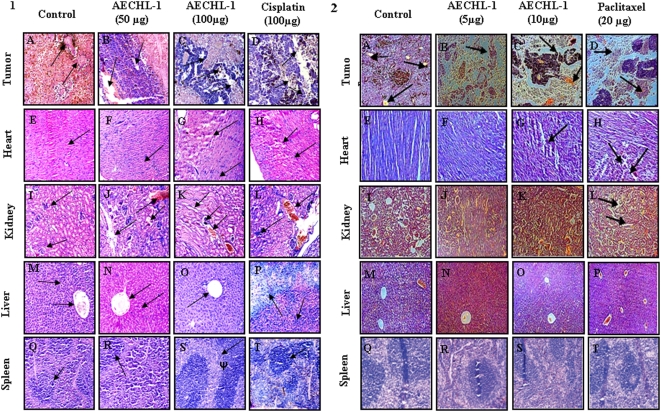
Histological analysis of tumor tissue and other organs in C57BL/6 and
nude mice.(1) Representative H&E-stained sections from B16F10 allograft
tumors and the characteristics of these tumors were analyzed
(1A–1D). Morphological characteristics of heart
(1E–1H), kidney (1I–1L), liver (1M–1P) and
spleen (1Q–1T), six mice were used in each set of experiments.
(2) Representative H&E-stained sections from MCF-7 xenograft
tumors and the characteristics of these tumors were analyzed
(2A–2D). Morphological characteristics of heart
(2E–2H), kidney (2I–2L) and liver (2M–2P),
spleen (2Q–2T), three mice were used in each set of
experiments.